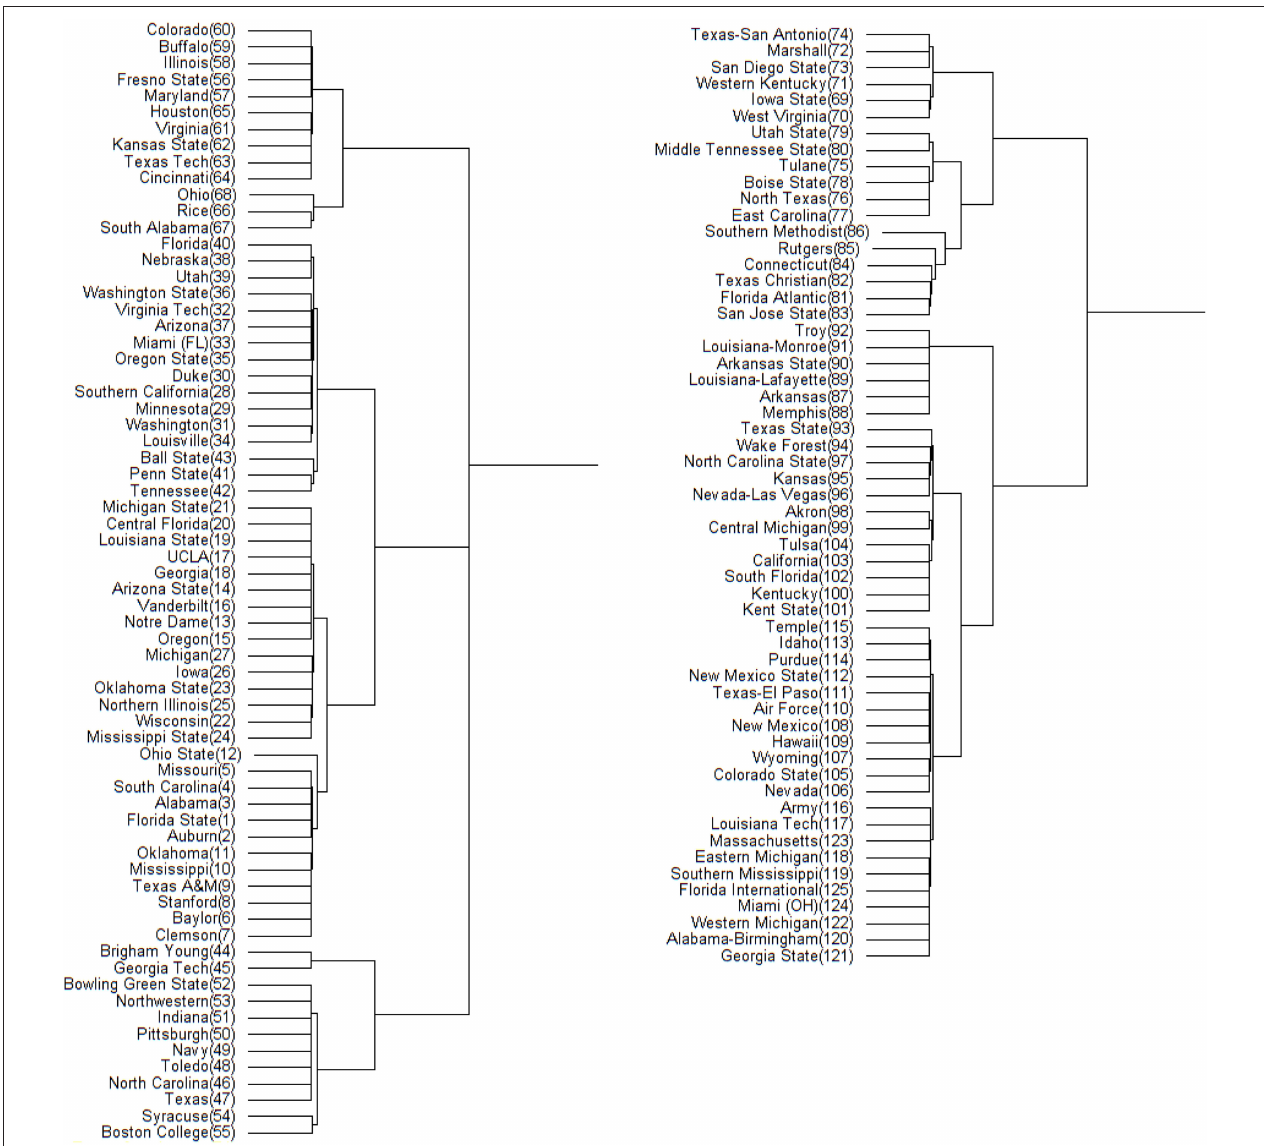
FIGURE 5 | Hamiltonian distance based DCG tree for the 2013 NCAA football season. The tree has been cut at its highest level for ease of presentation. The branch containing the top 68 teams is displayed on left; the remaining teams are displayed on right. The number in the parentheses next to each team name is its position in ˆ σ